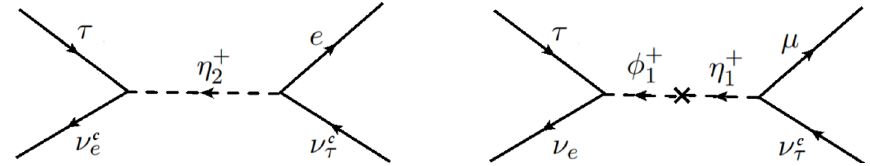
Figure 8 . Feynman diagrams contributing to (cid:28) decay via the exchange of charged scalars in the SU(2) H model. The diagram on the left contributes to the normal (cid:28) decay, (cid:28) ! e(cid:23) (cid:28) (cid:23) e . There is a similar diagram mediated by (cid:17) + leading to (cid:28) ! (cid:22)(cid:23) (cid:28) (cid:23) (cid:22) with identical strength. The diagram on 2 the right contributes to a new decay channel, (cid:28) ! (cid:22)(cid:23) e (cid:23) (cid:28) , with an analogous diagram mediated by (cid:30) + = (cid:17) + for (cid:28) ! e(cid:23) (cid:22) (cid:23) (cid:28) 2 2